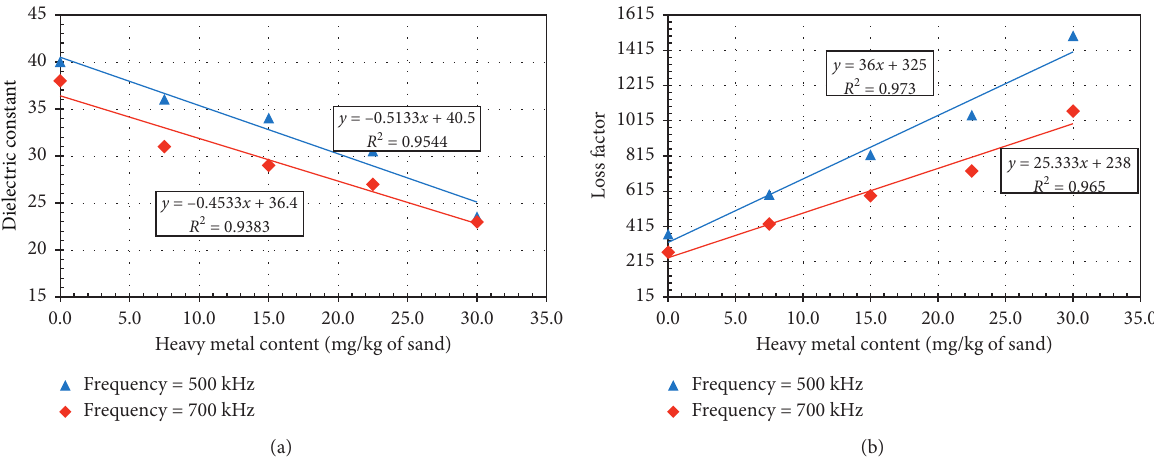
Figure 8: Regression analysis of complex permittivity and Cd content. (a) Dielectric constant versus Cd content. (b) Loss factor versus Cd content.